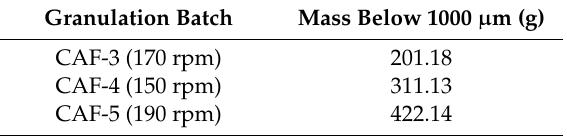
Figure 12. Plot showing the log normal distribution of granules processed with 150 rpm, 170 rpm (CAF-3) and 190 rpm (CAF-5). Table 6. Table describing the mass of granules below 1000 μ m for different input granulation batches.